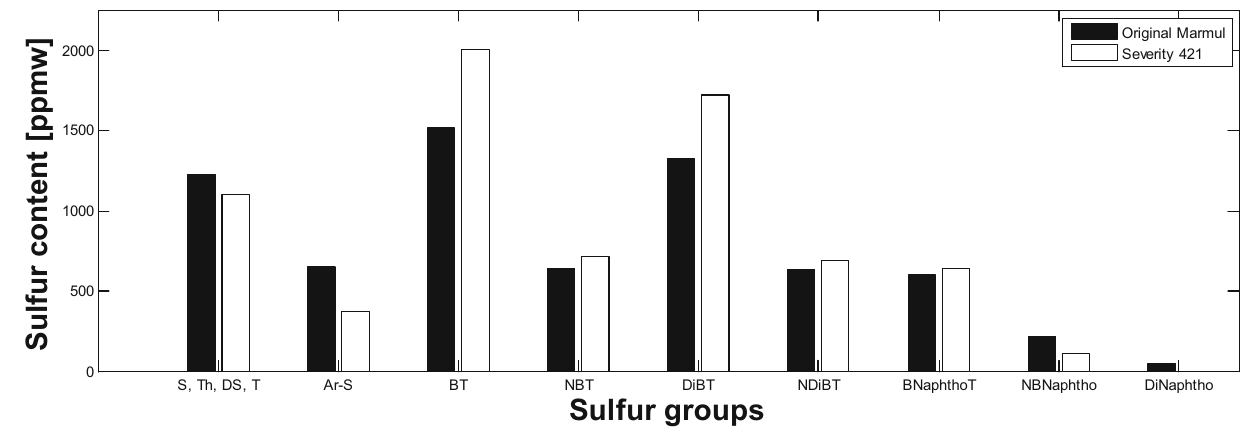
Fig. 7 Mass distribution of sulphur as function of organic sulphur types. ( Th thiophene, DS disulphides, Ar - S aryl sulphides, BT